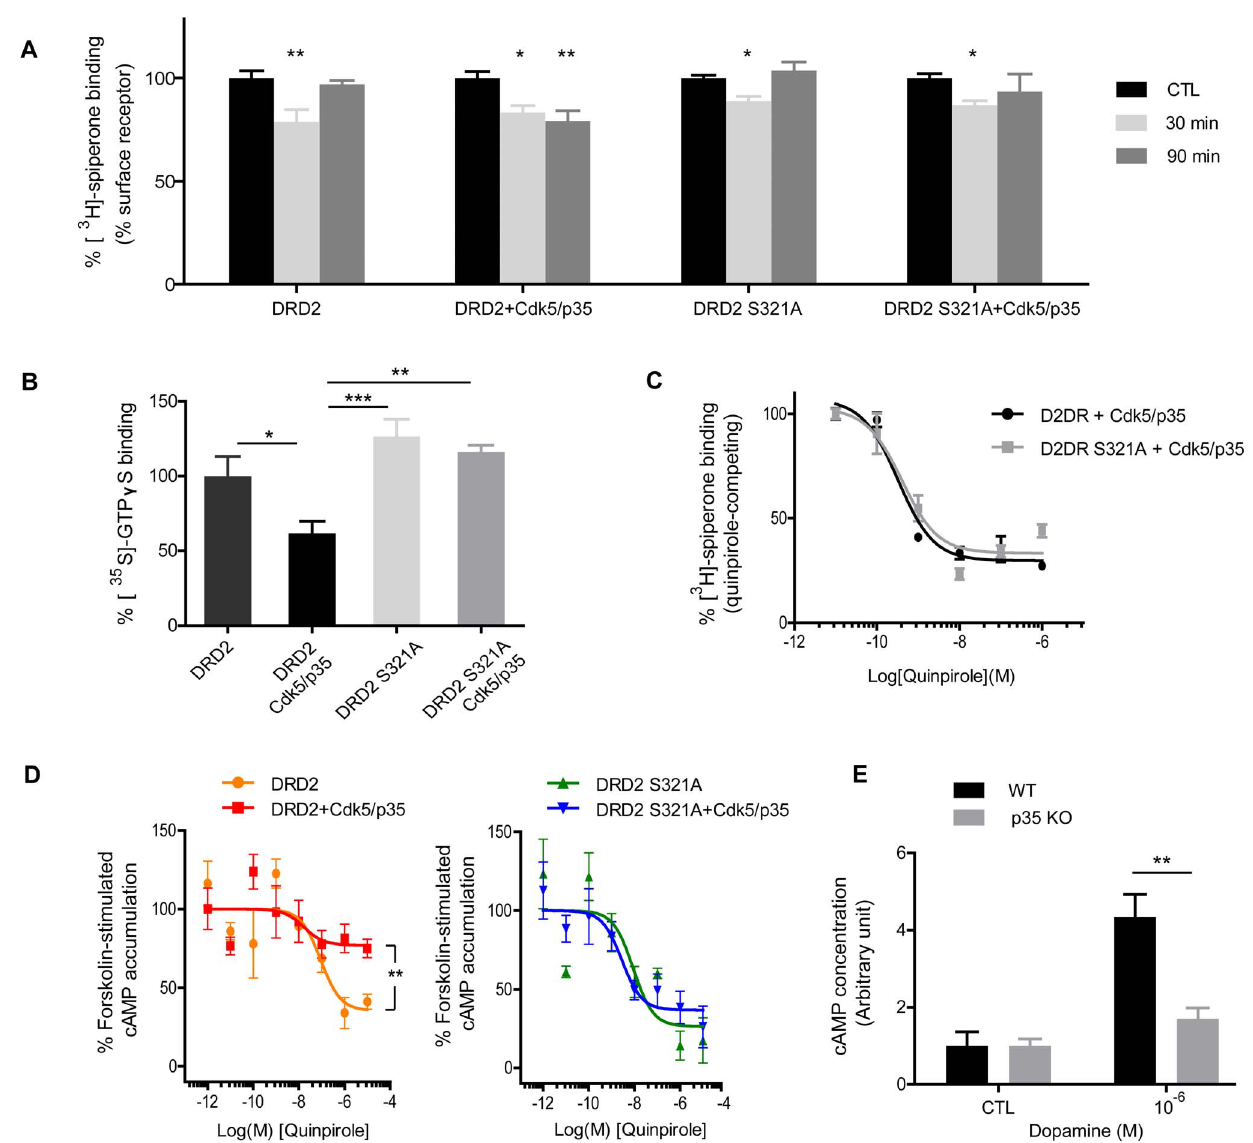
Figure 4. Cdk5-mediated phosphorylation attenuates DRD2 surface expression and downstream signaling. (A) DRD2 surface expression measured by [ 3 H]-spiperone binding assay. Transfected HEK293 cells were stimulated with 1 m M quinpirole for the indicated time and harvested, followed by 3 nM [ 3 H]-spiperone treatment for 3 h. Radioactivity was measured and surface signals were calculated. Error bars represent mean 6 SE (n=8; *p , 0.05, **p , 0.01; One-way ANOVA with Dunnett post hoc test: compare all columns vs. control column). (B) [ 35 S]-GTP c S binding assay. Cell membranes were prepared from the cells transfected as indicated. Membrane preparations were incubated with 1 m M quinpirole followed by 3 nM [ 35 S]-GTP c S for 90 min. Error bars represent mean 6 SE (n=8; *p , 0.05, **p , 0.01, ***p , 0.001; One-way ANOVA with Bonferroni post hoc test: compare all pairs of columns). (C) Quinpirole-competing [ 3 H]-spiperone binding assay. Membrane preparations from transfected cells were incubated with 0.01 nM [ 3 H]-spiperone and increasing concentrations of quinpirole for 30 min. Non-linear regression was obtained by GraphPad. Error bars indicate mean 6 SE (n=3). (D) cAMP enzyme immunoassays in transfected HEK 293 cells. Transfected cells were pretreated with 10 m M rolipram for 1 h, and subsequently co-treated with 0.1 m M forskolin and increasing concentrations of quinpirole for 30 min. Non-linear regression was obtained by GraphPad. Error bars represent mean 6 SE (n=4; **p , 0.01; two-tailed t -tests). (E) Cultured striatal neurons from wild type and p35 knockout embryos (DIV 7) were treated with 10 m M rolipram for 1 h followed by 1 m M dopamine for 1 h. Error bars represent mean 6 SE (n=4; ** p , 0.01; two-tailed t -tests).